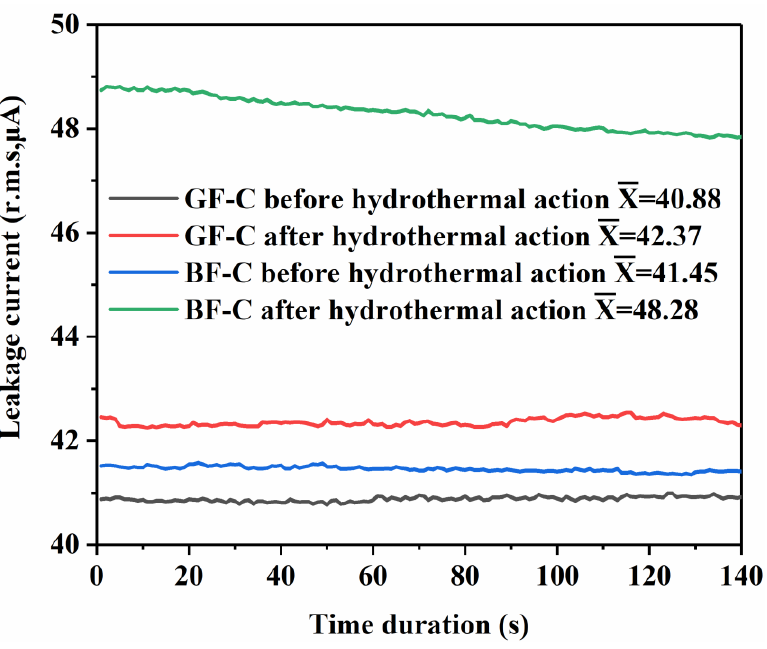
Figure 8. Leakage current amplitude before and after hydrothermal action.